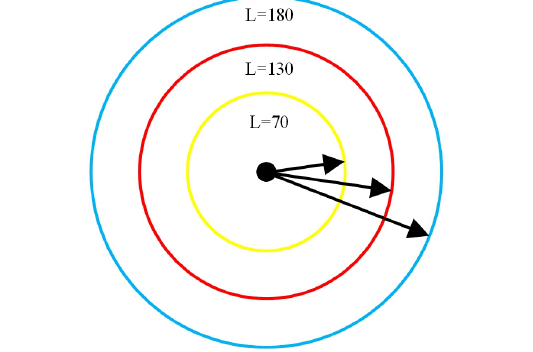
Figure 10. Schematic of the image